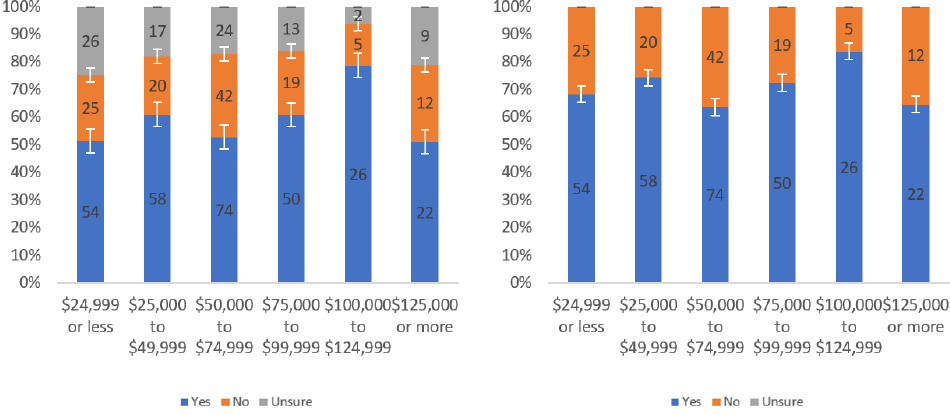
Figure 35. Responses regarding usefulness in judging trustworthiness by income level including ( left ) and excluding ( right ) unsure responses.